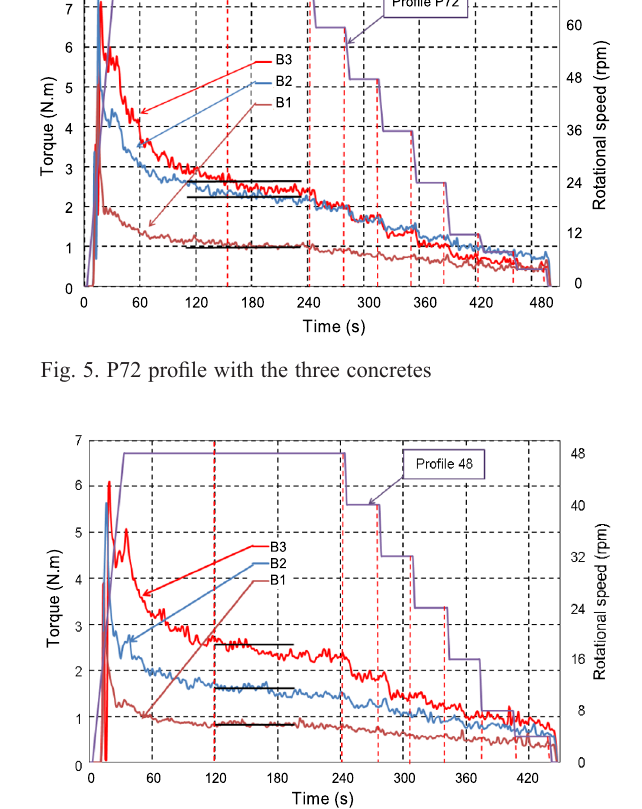
Fig. 8. Results of the container with a diameter of 30